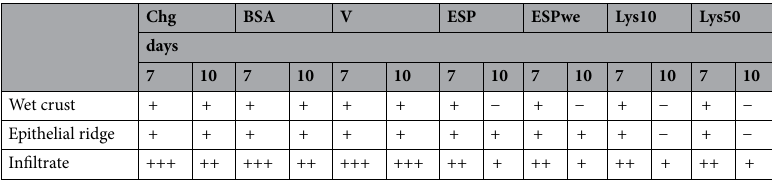
Table 1. Semi-quantitative analysis of skin pathomorphological changes after injury.